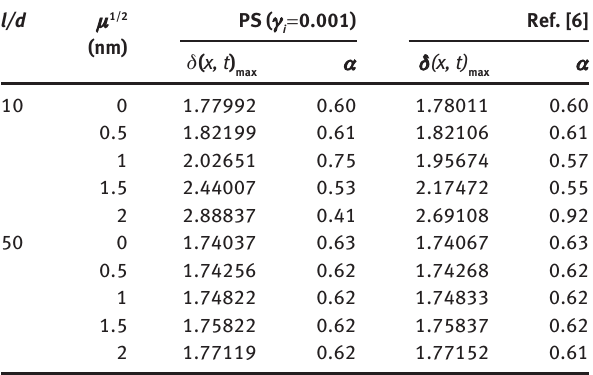
Figure 5 Maximum relative deflection versus velocity parameter, l / d = 50, k Table 5 Maximum relative deflection and corresponding velocity parameter in Figures 4 and 5, k